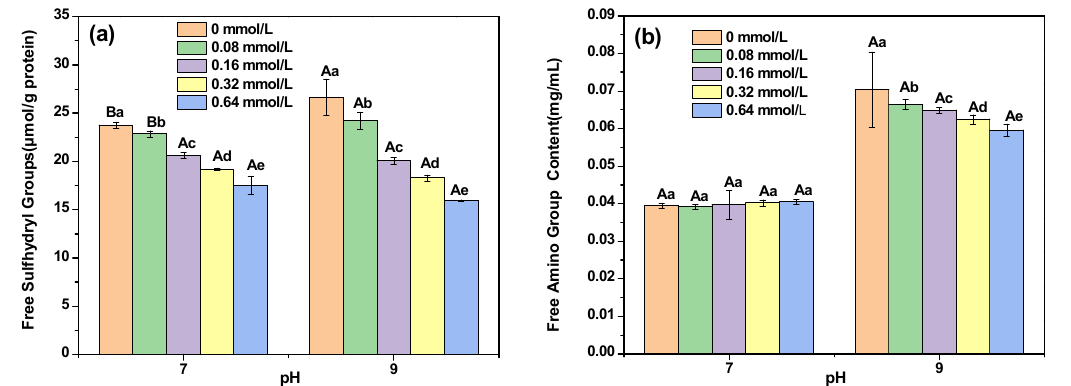
Figure 3. Analysis of free sulfhydryl content ( a ) and free amino group ( b ) content of decolorized highland barley protein (DHBP)–proanthocyanidin (PC) complexes. a–e mean values with different letters under the same conditions; A,B mean values with different letters under different conditions, indicating significant differences ( p < 0.05), respectively.